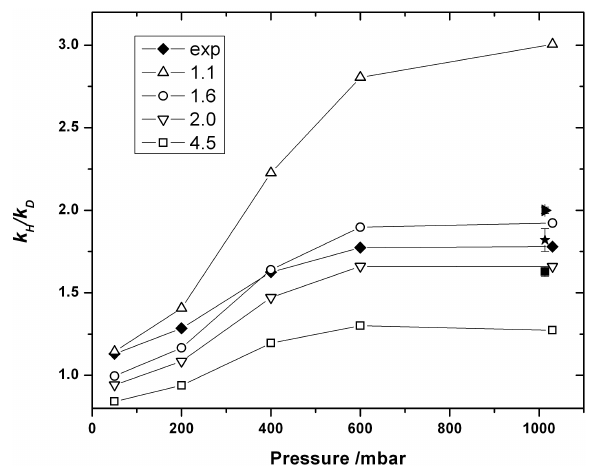
Fig. 4. Quantum yields from JPL (Sander et al., 2006) in the radical channel, and in the molecular channel at two different pressures, scaled by the photolysis lamp spectrum (Fig. 1).